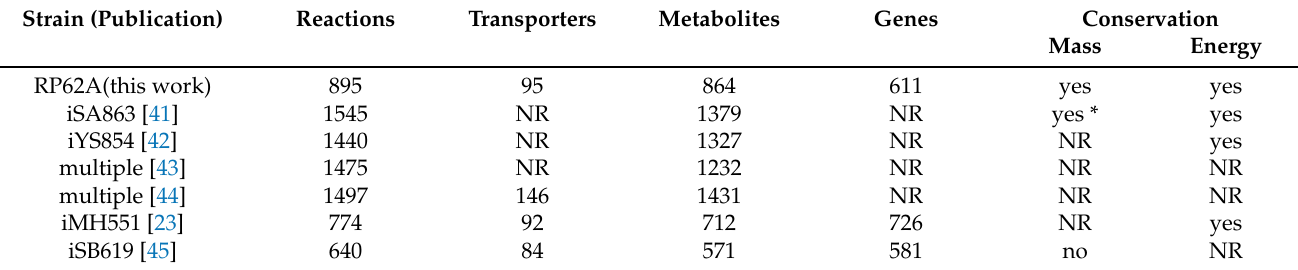
Table 1. Comparison of model properties with previous S. aureus models. NR: Not reported; * excluding reactions with unspecified macromolecular